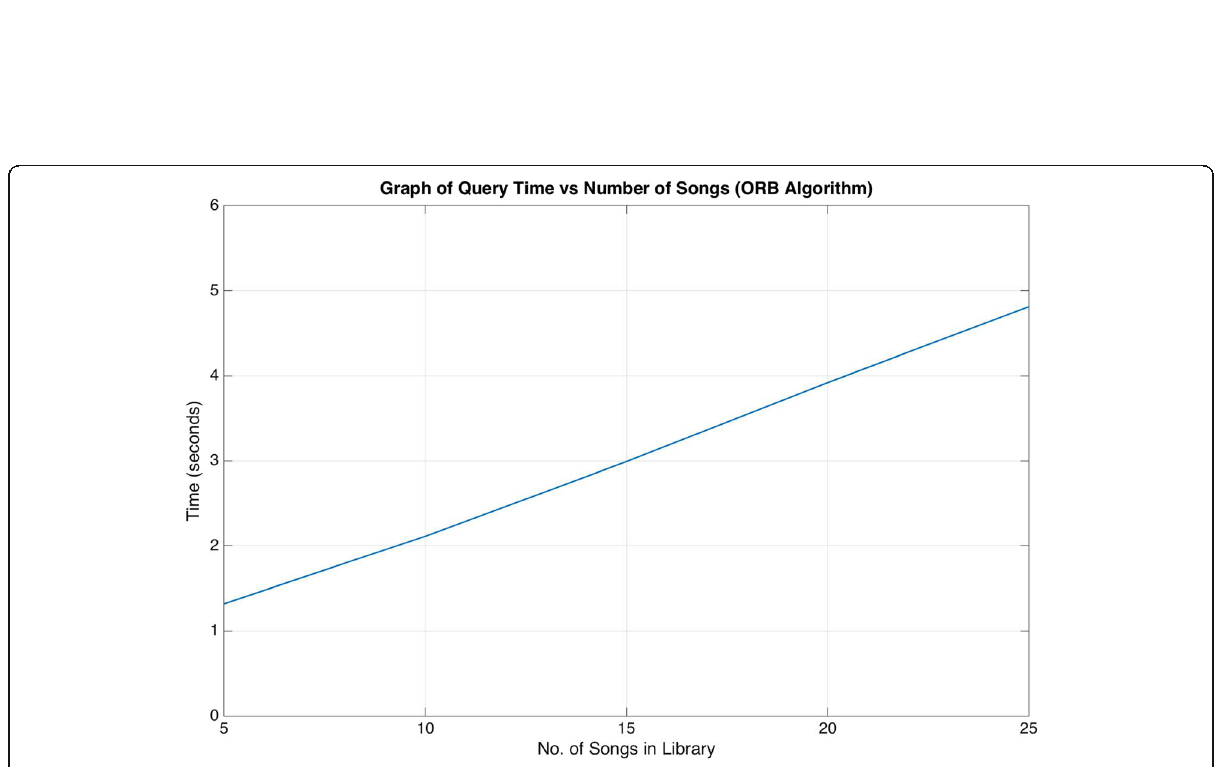
Fig. 9 Graph of time taken for query to search and match songs in database (Shazam). In this figure, results were shown for the time taken for a query to be searched and matched. This was done for libraries of songs. This was done for the Shazam algorithm. The results showed an approximately linear relationship, although five songs took a shorter time to for the audio sample to be queried